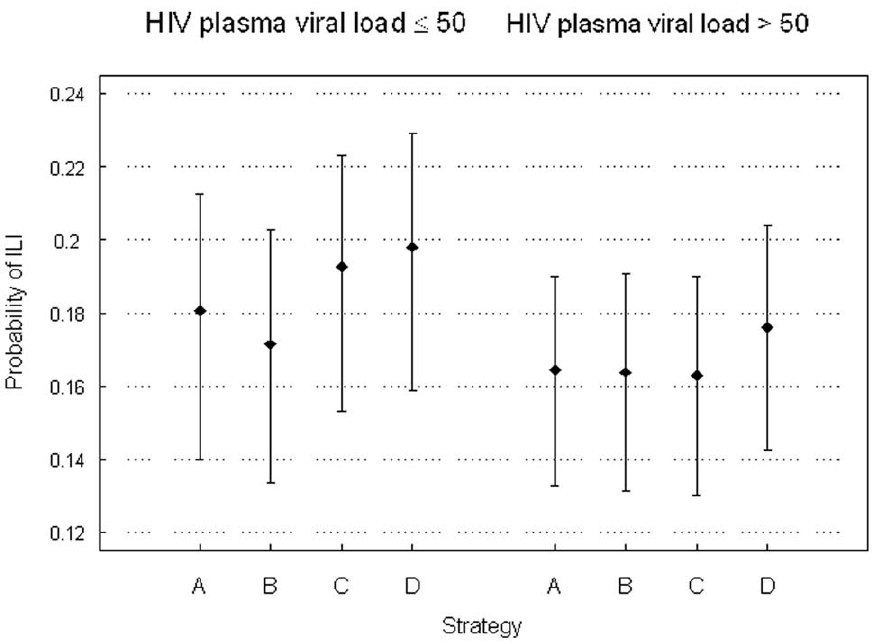
Figure 3. Mean of the probabilities of ILI and 95% credibility interval for each strategy by baseline pVL. Strategy A: single standard dose + single standard dose booster; Strategy B: double dose + double dose booster; Strategy C: single standard dose + no booster; Strategy D: standard of care.